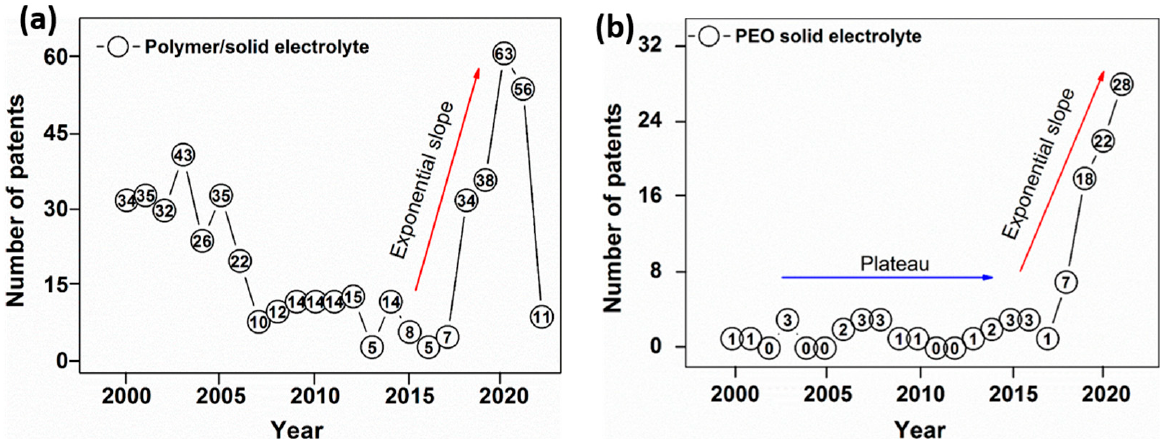
Figure 8. Overview of patent applications on polymer ( a ) and polyethylene oxide ( b ) solid electrolytes in 2000–2020.